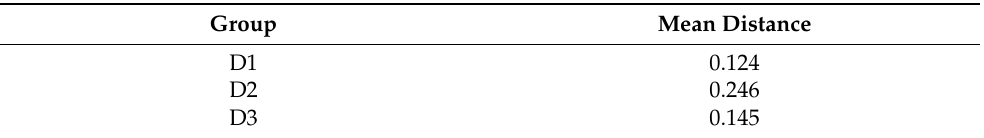
Table 3. Mean within-group distances (D1, D2 and D3) of the D. novemcinctus Ig-like ectodomains calculated in MEGAX.